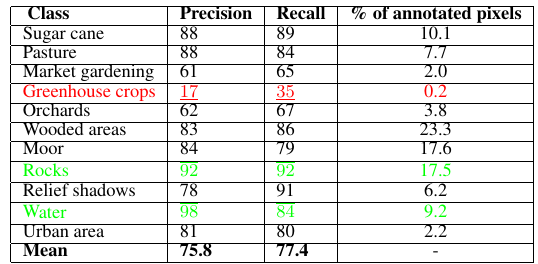
Table 2. Precision and recall by class for the DSLCC on the test set (176,166 pixels).